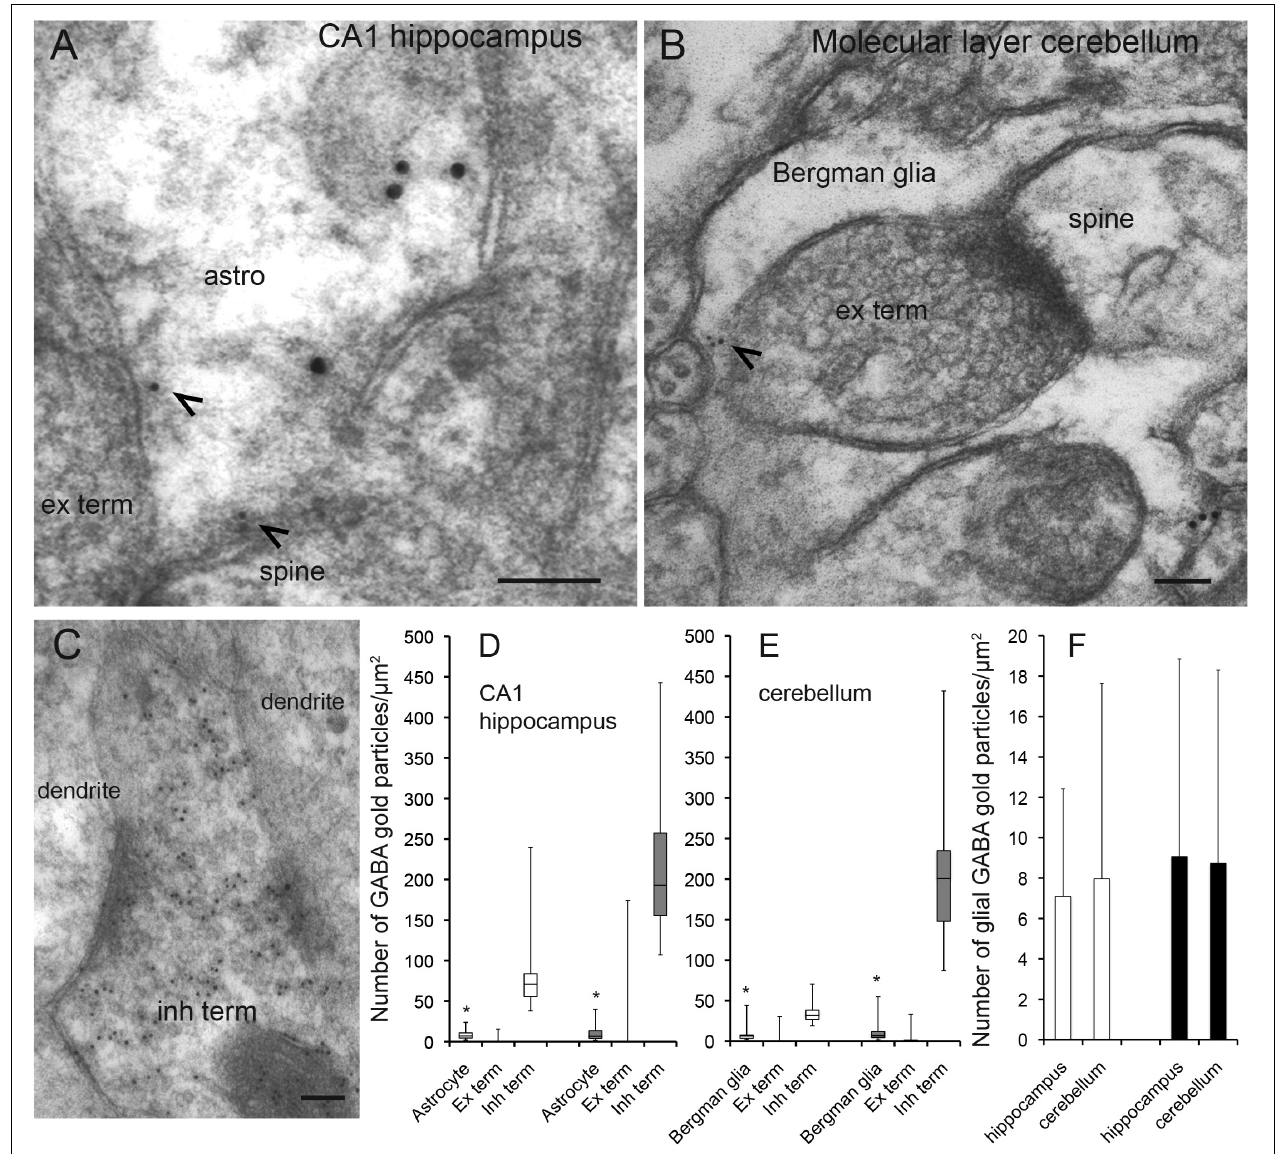
FIGURE 1 | GABA is localized in CA1 hippocampal astrocytes and Bergman glia. (A,B) Electron micrographs showing GABA immunogold particles (small gold particles, arrowheads) in CA1 stratum radiatum astrocytes (A) and cerebellar Bergman glia (B) containing labeling for glutamine synthetase (large gold particles). The astroglial cells make contact with presynaptic terminals (ex term) forming asymmetric synapses with postsynaptic dendritic spines (spine). (C) GABA labeling in a nerve terminal with an inhibitory appearance (inh term) forming symmetric synapses with dendritic shafts (dendrite) in the CA1 str radiatum. Scale bars in (A–C) , 100 nm. (D,E) Quantitative representation of the density GABA immunogold particles (number of gold particles/ µ m 2 in astroglial processes labeled for glutamine synthetase (Astrocyte/Bergmann glia), terminals making asymmetric synapses with dendritic spines (Ex term) and terminals making symmetric synapses with dendritic shafts (Inh term) in the CA1 hippocampus and the cerebellum). Box plots in (C,D) [two rats (open and filled bars)] show the lower and upper quartiles and the median. The whiskers show the minimum and the maximum density values. *The values in astrocytes and Bergman glia (astrocytes n = 53 and 42, Bergman glia n = 39 and 39) are significantly different from the values in excitatory terminals (ex term, hippocampus n = 90 and 96, cerebellum n = 85 and 67) and inhibitory terminals (inh term, hippocampus n = 38 and 43, cerebellum 23 and 25) ( p < 0.05, Mann–Whitney U -test, two tails, SPSS). The bars in (F) show the mean number of GABA gold particles/ µ m2 ± SD in astroglia in the hippocampus and the cerebellum in the two rats presented in (D,E) . There was no significant difference between the GABA signal in CA1 hippocampal astrocytes and Bergmann glia ( p > 0.05, Mann–Whitney U -test, two tails,